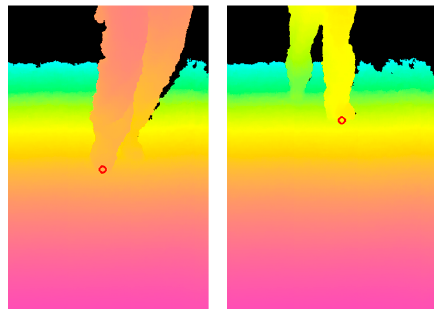
Figure 15. Estimation error in the dynamic hazardous object detection.